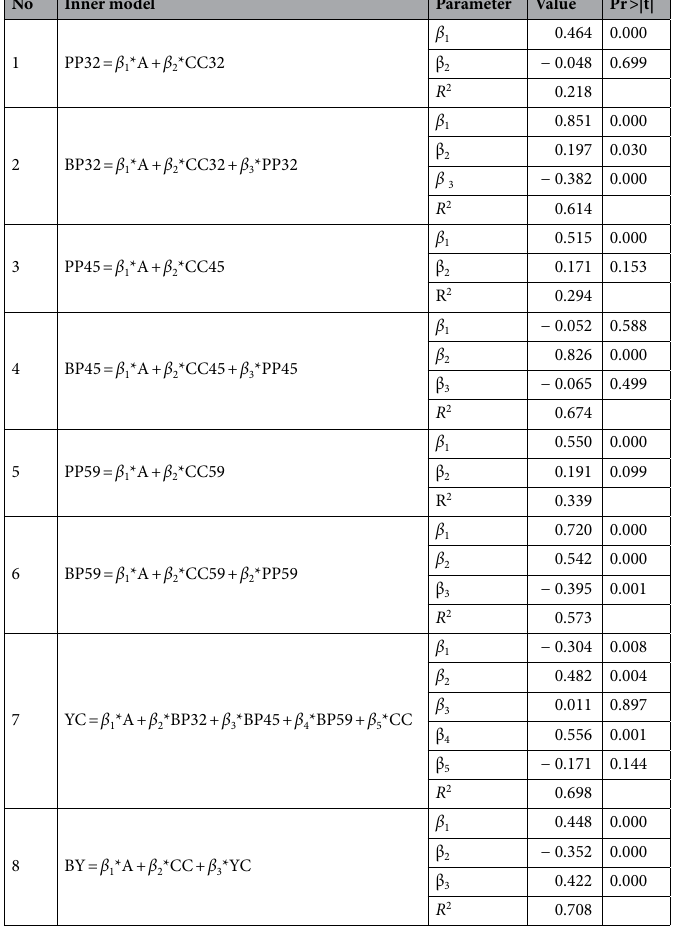
Table 3. Parameters of regression models for latent variables. *Refer to Table 1 for the legend.